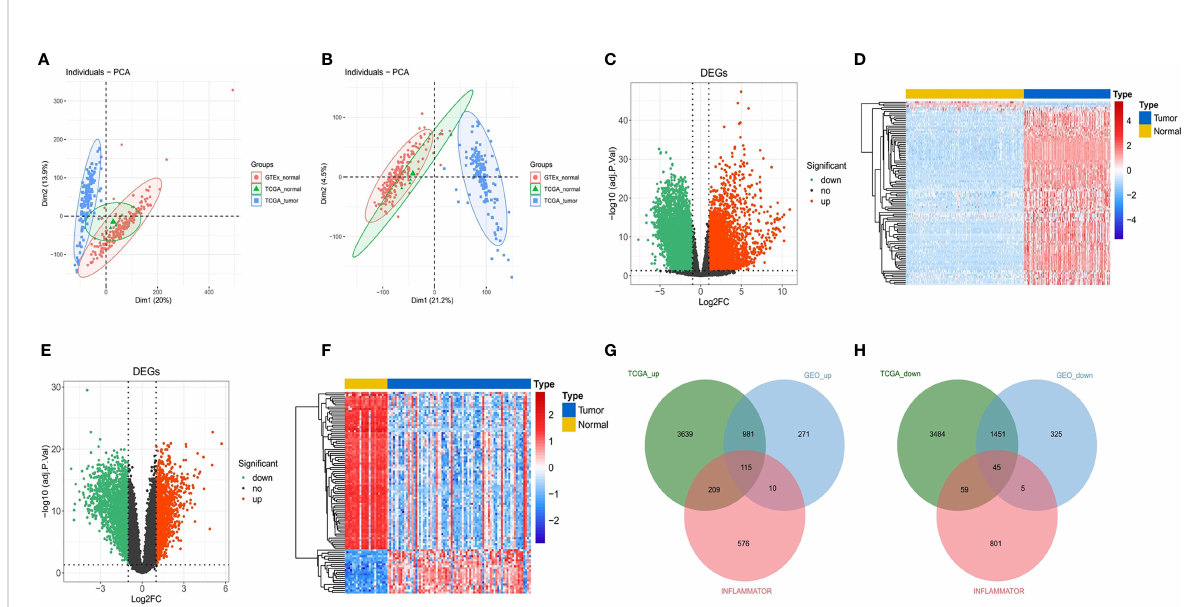
FIGURE 2 Identi fi cation of DEGs and DE-IRGs. (A) Primordial principal component analysis (PCA) of all samples. (B) PCA of all samples after batch correction. (C) Volcano plot for DEGs between TCGA and GTEx. The transverse reference line represents -log10(adjust. P -value) = 0.05, and the longitudinal reference line represents log2FC = ± 1. (D) Heat map (Top100) for DEGs between TCGA and GTEx. Blue indicates low expression, and red indicates high expression. (E, F) Volcano plot and heat map (Top100) for DEGs in the GSE4290 dataset. (G, H) Upregulated immune- related genes and downregulated immune-related genes after matching the DEGs from the above analyses.